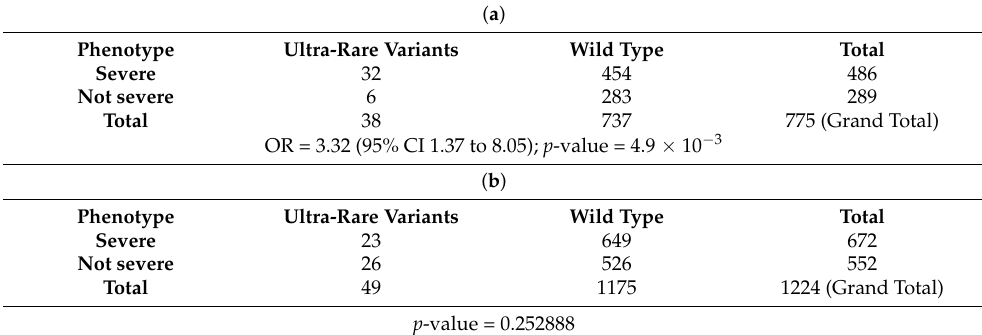
Table 1. ( a ) ADAMTS13 ultra-rare variants correlation with COVID-19 severity in female cohort. ( b ) ADAMTS13 ultra-rare variants correlation with COVID-19 severity in male